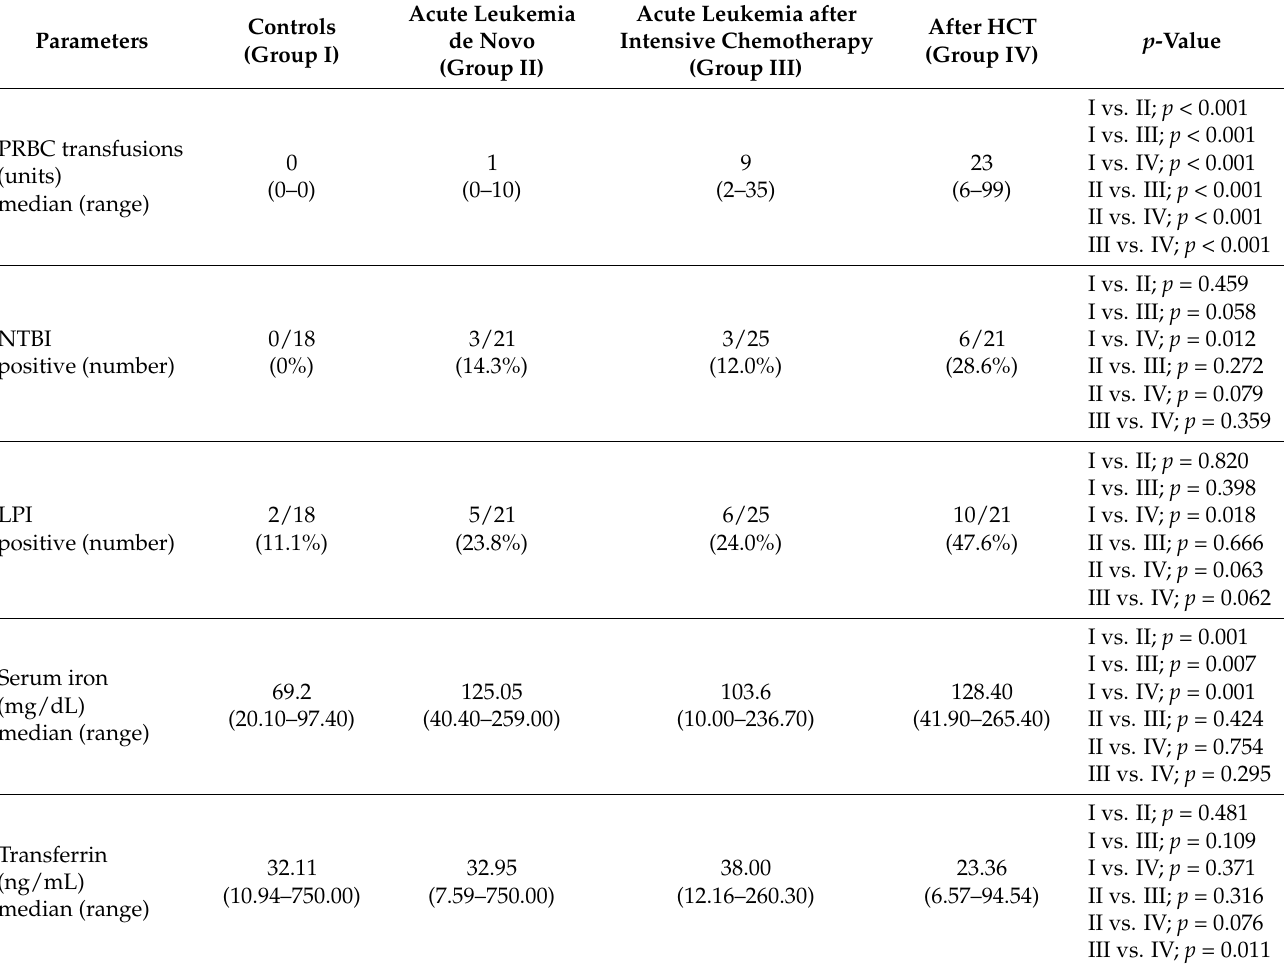
Table 3. Differences between parameters of iron